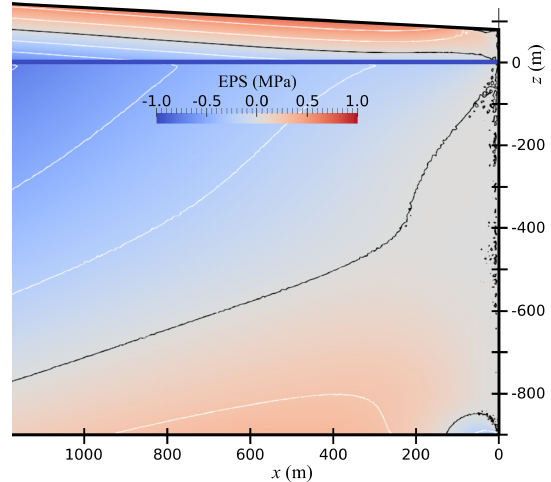
Figure 3. Effective principal stress map of the terminus of the glacier before the cutting of a notch, with d w = 900m, h t = 980m, α = 3 ◦ and C = 5 . 623 × 10 6 Pam − 1 / 3 s 1 / 3 . The black contour de- notes EPS = 0MPa; white contours are spaced at 0.25MPa inter- vals.